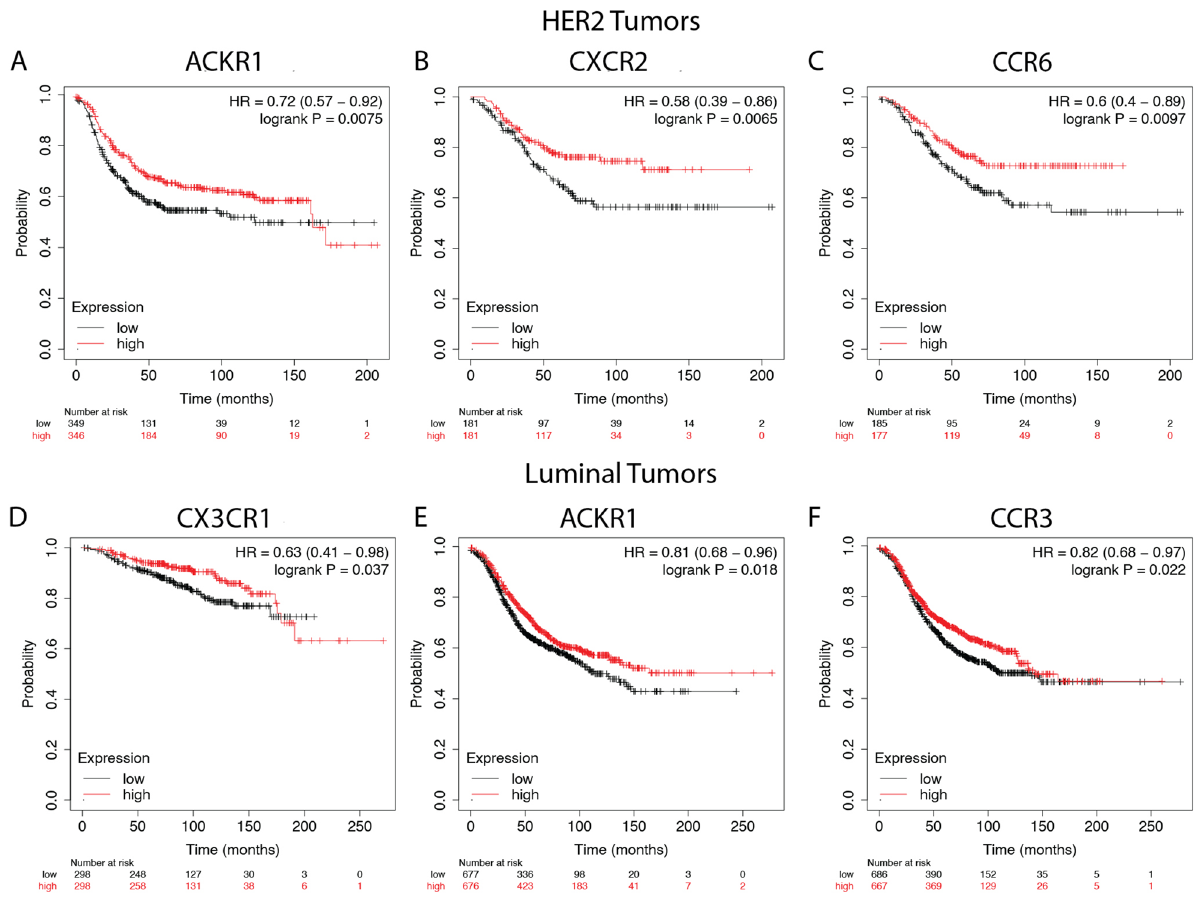
Figure 10. Chemokine receptors identified as significantly correlated with overall survival rate for breast cancer tumor samples of HER2 and luminal subtypes. Kaplan–Meier curves of overall survival based on KMplotter mRNA gene chip expression of chemokine receptors in breast cancer patients. Red line represents higher expression and black line represents lower expression. The receptors in ( A ) ACKR1, ( B ) CXCR2, and ( C ) CCR6, were significant for HER2 enriched subtype ( D ) CX3CR1 was correlated with the luminal A subtype. ( E ) ACKR1 and ( F ) CCR3 expression correlated with luminal B